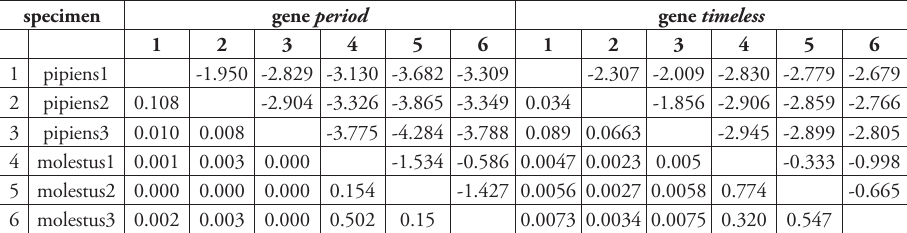
Table 4. Codon-based Test of Neutrality between C. pipiens f. “pipiens” and C. pipiens f. “molestus”.